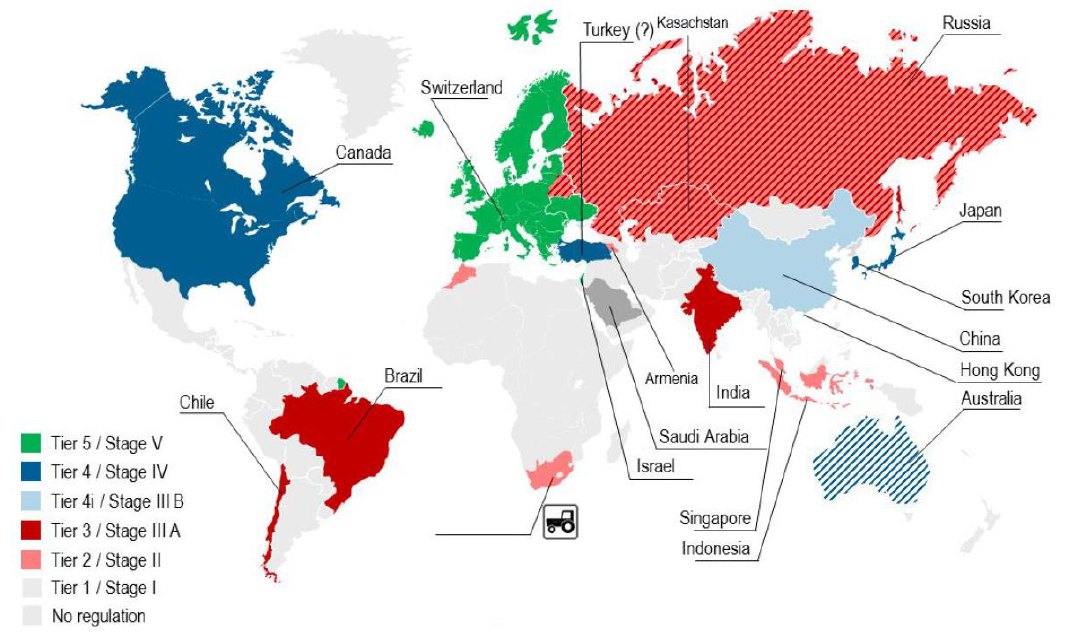
Fig. 4. Emission standards in individual countries [8]